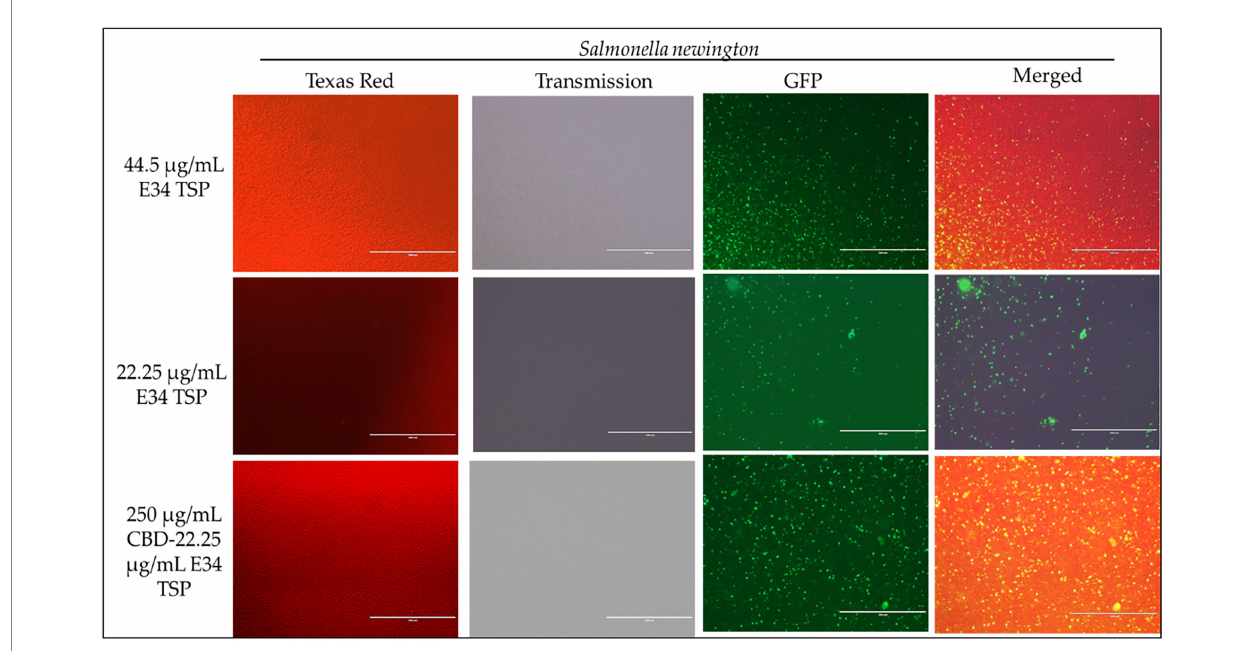
FIGURE 8 Immunofluorescence analysis of S . Newington (SN) treated to low concentrations of E34 TSP; 44.5 μ g/ml, 22.25 μ g/ml, and a combination treatment of 250 μ g/ml CBD extract +22.25 μ g/ml E34 TSP. The immunofluorescence images showed that the combination treatment (CBD extract and E34 TSP) had poorer membrane disruptive activities against S . Newington as compared to the monotreatment with E34